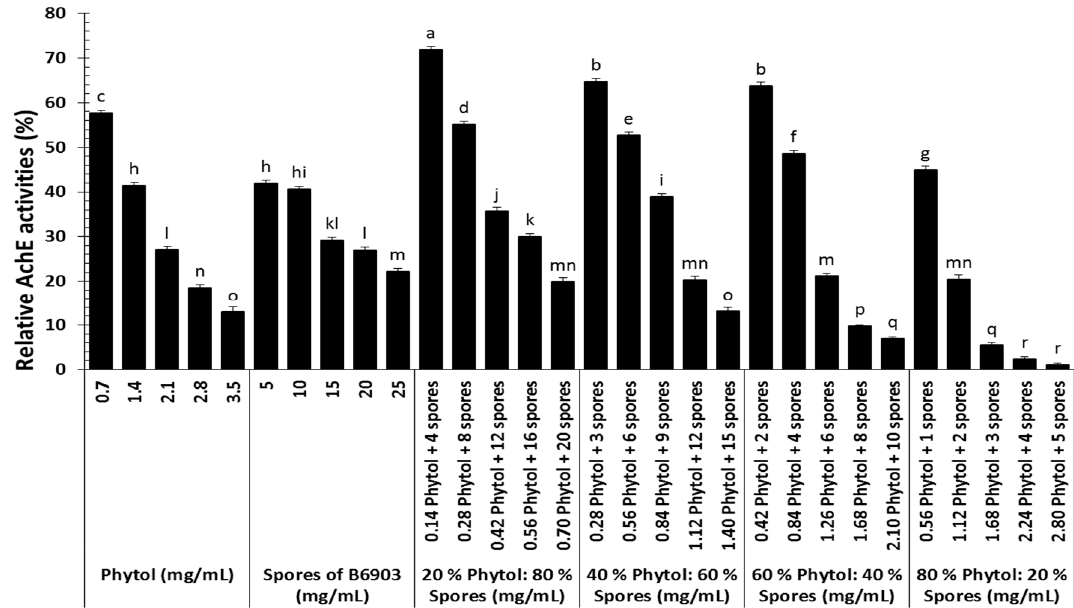
Figure 6. Acetylcholinesterase (AchE) activities (%) of Oligonychus afrasiaticus (McGregor) fed on date palm leaf disks treated with different combinations of phytol and spores of Beauveria bassiana B6903 relative to control. Bars (means ± SE) followed by different letter(s) are significantly different (Fisher’s LSD test, α = 0.05).